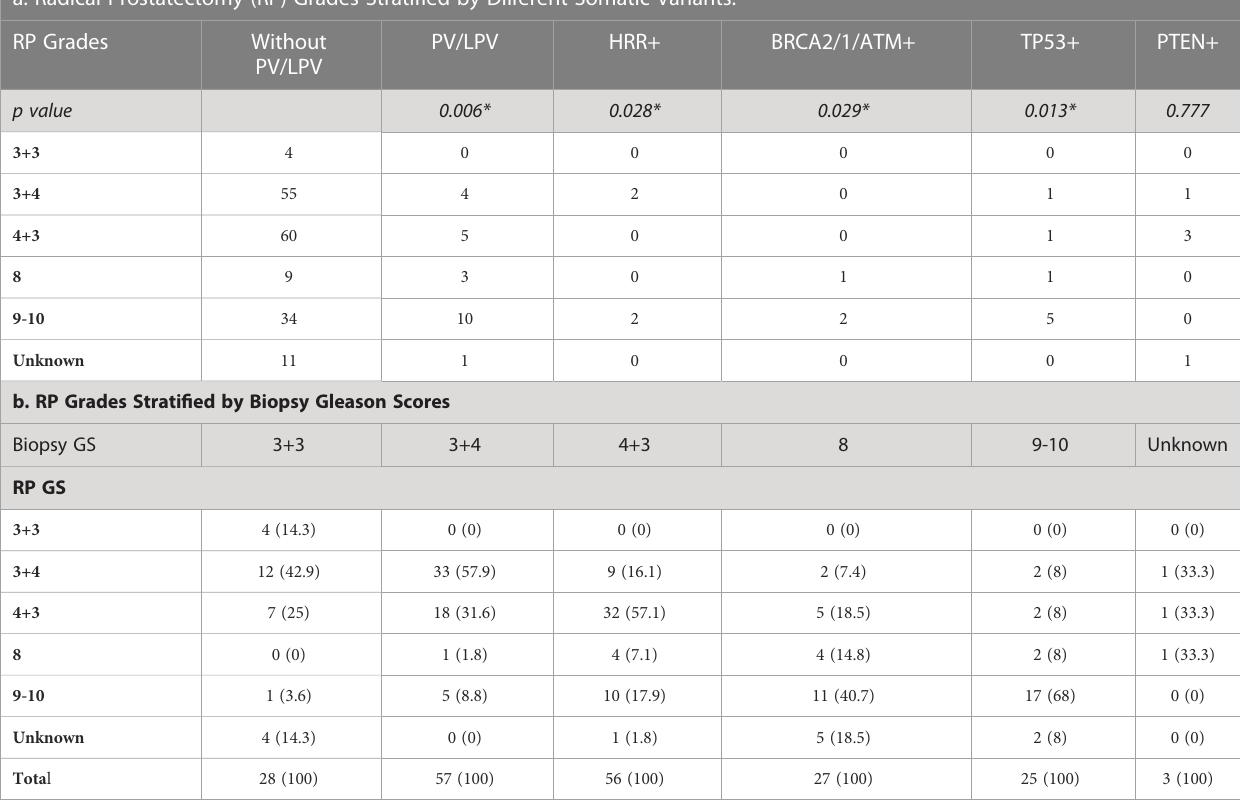
TABLE 3 Somatic tested patients underwent radical prostatectomy (n=196). a. Radical Prostatectomy (RP) Grades Strati fi ed by Different Somatic